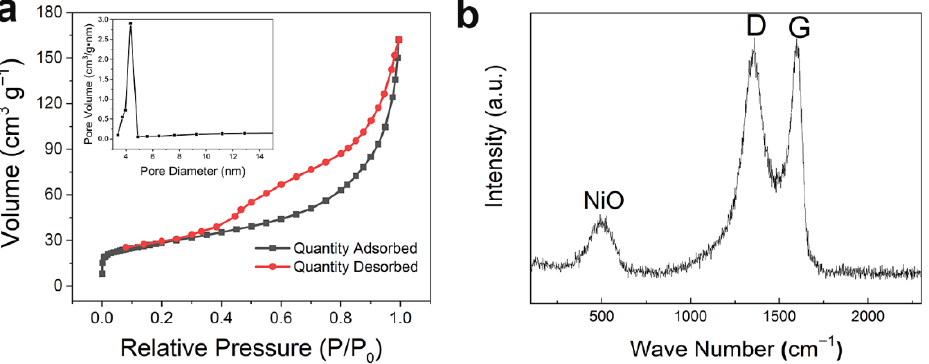
Figure 4. ( a ) N 2 adsorption–desorption isotherm and pore size distribution (BJH) model of the NiO- rGO composite; ( b ) Raman spectra of the NiO-rGO